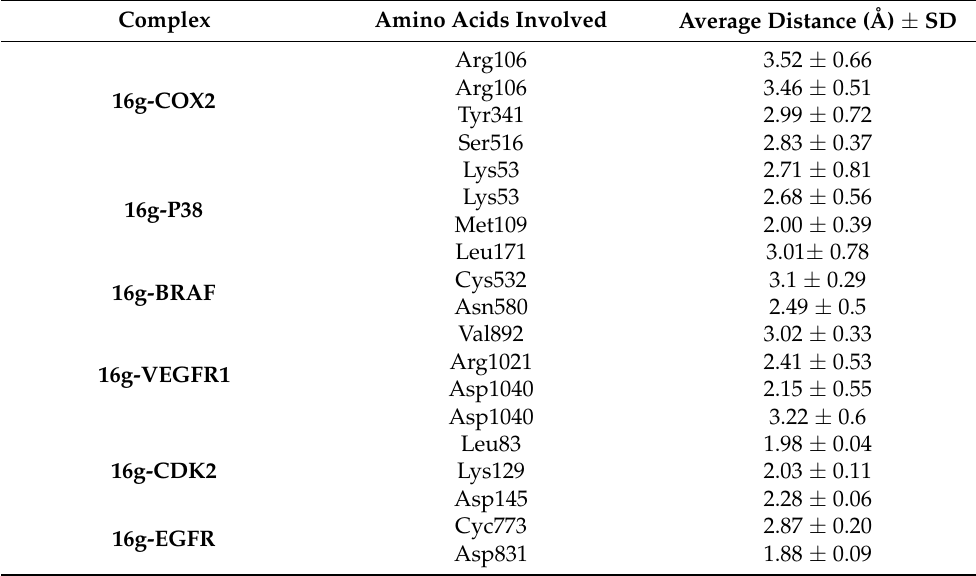
Table 5. The average distances of the formed hydrogen bond interactions in the six complexes.